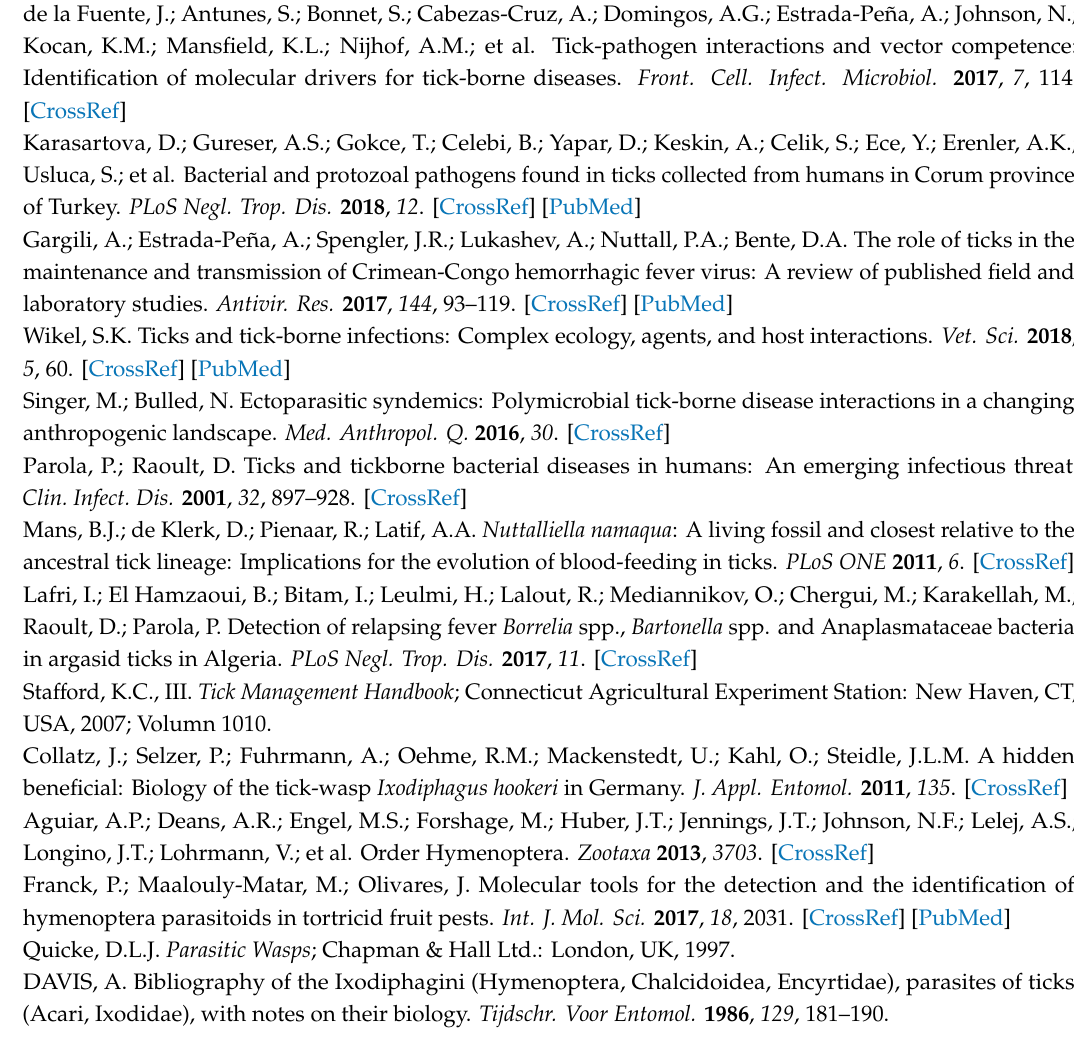
Table S1: Analytical specificities: a panel of arthropods and bacterial species tested with Hymenoptera-specific 28S rRNA based standard PCR